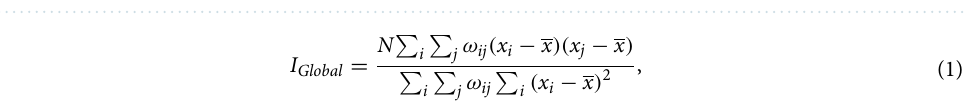
Figure 1. Location of the Yangtze River Delta. Map was generated by ArcGIS 10.2 (http:// www. esri. com/ softw are/ arcgis/ arcgis- for- deskt